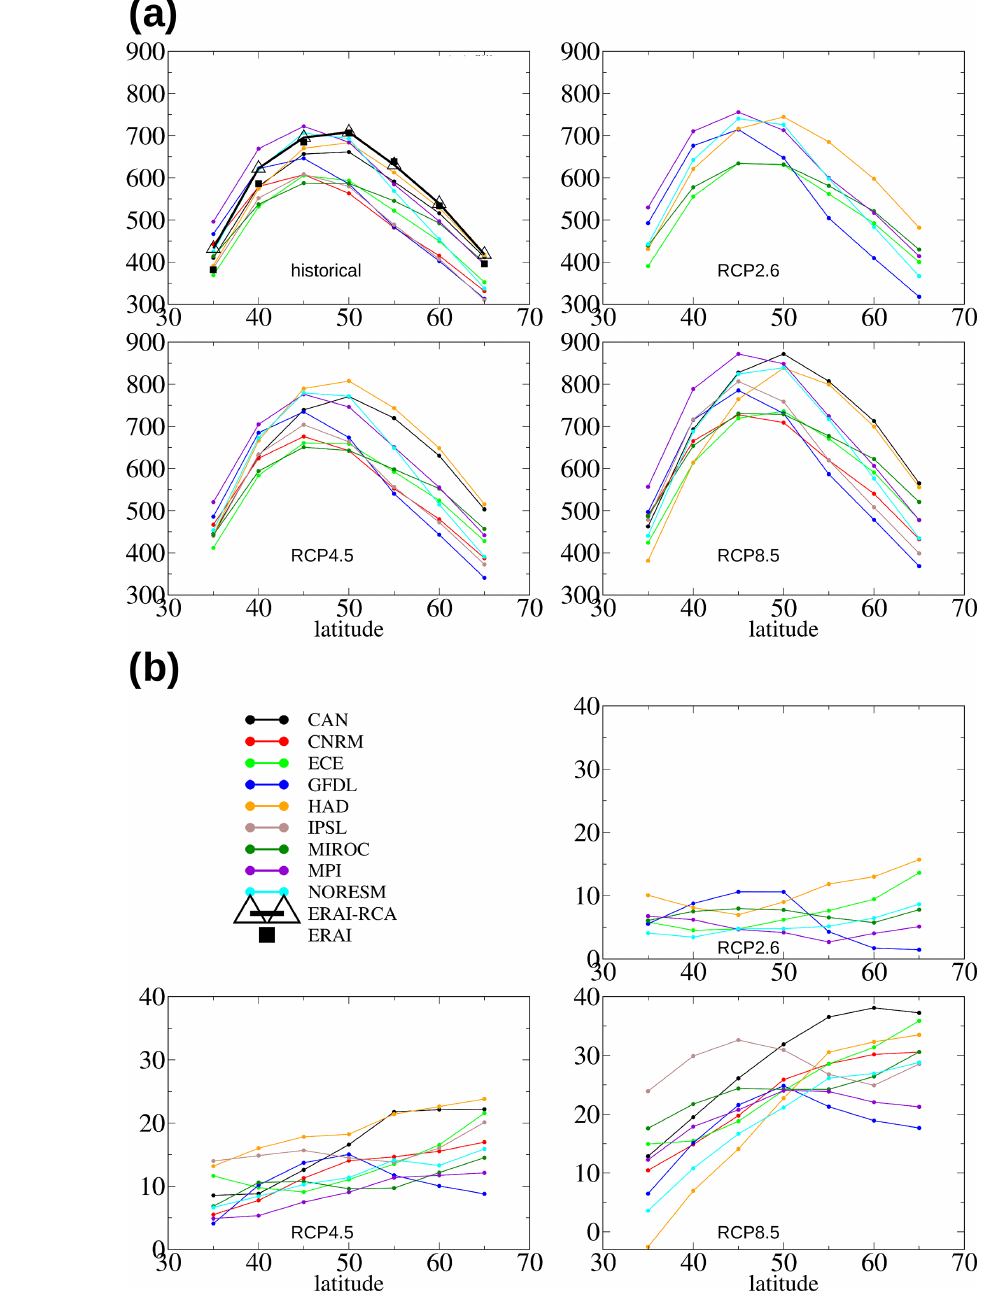
Figure 2. (a) The 85th percentiles of IVT [kgm − 1 s − 1 ] at 10 ◦ W for all models and the historical period (1970–1999, upper left) and the RCP climate scenarios (2070–2099). The algorithm uses the values to find ARs. (b) Relative change [%] in the IVT thresholds in future scenarios relative to the respective historical